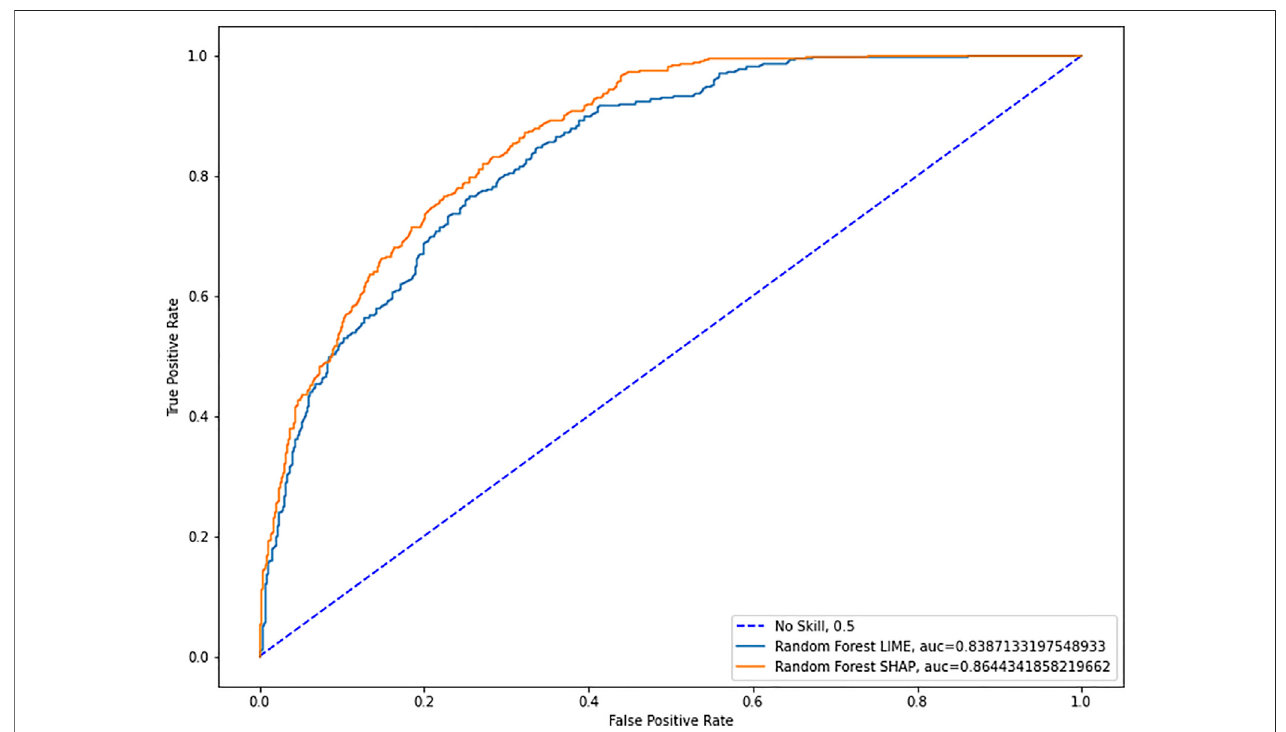
FIGURE 3 | Lime and SHAP ROC curves.